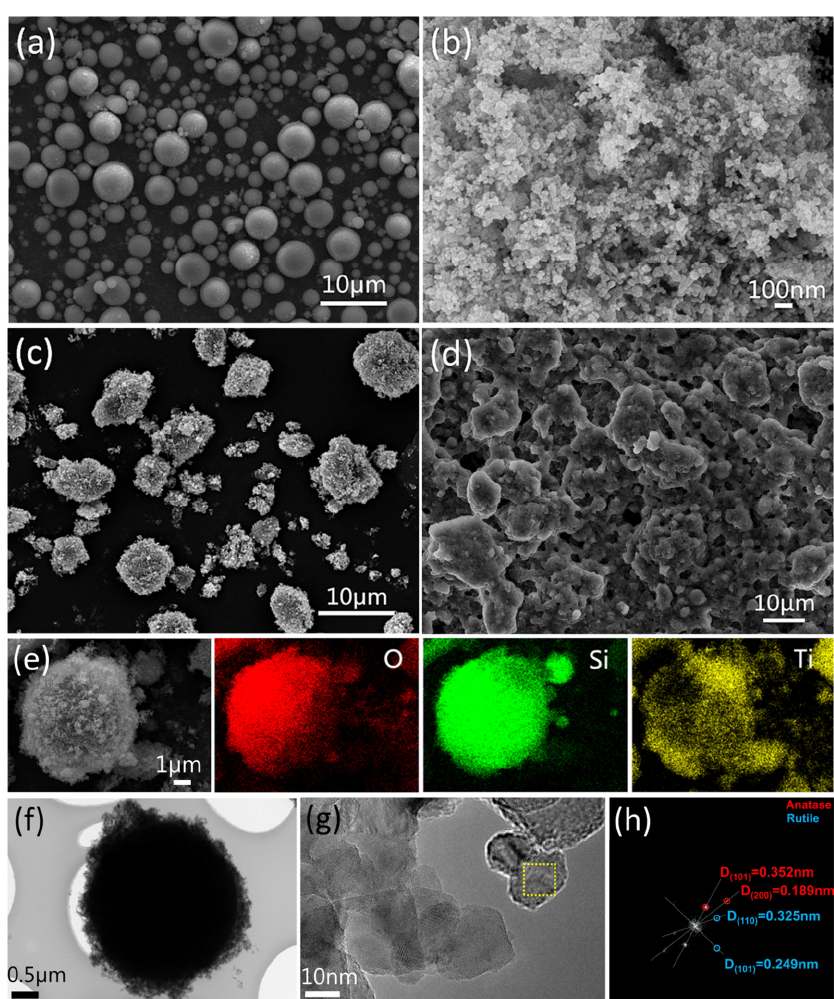
Figure 7. SEM images and EDS element mapping data of A-SiO 2 , N-TiO 2 , and A-SiO 2 /N-TiO 2 . ( a ) SEM image of A-SiO 2 ; ( b ) SEM image of N-TiO 2 ; ( c ) SEM image of A-SiO 2 /N-TiO 2 ; ( d ) SEM image of the A-SiO 2 /N-TiO 2 @PDMS coating surface; ( e ) EDS element mapping images of O, Si, and Ti of A-SiO 2 /N-TiO 2 ; ( f ) TEM of A-SiO 2 /N-TiO 2 ; ( g ) HRTEM image of A-SiO 2 /N-TiO 2 ; ( h ) FFT analysis of a selected area of A-SiO 2 /N-TiO 2 . Figure 7f–h are TEM images of A-SiO 2 /N-TiO 2 . The morphology of A-SiO 2 /N-TiO 2